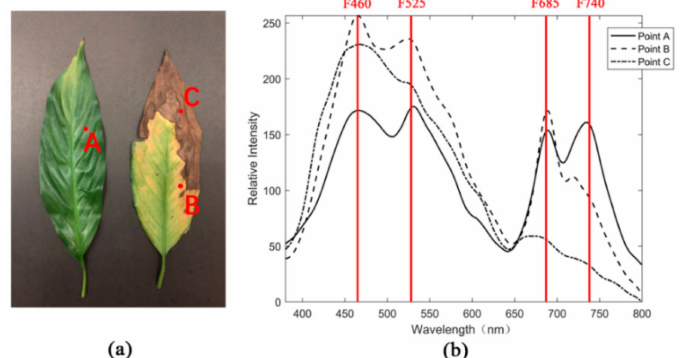
Figure 1. Induced continuous fluorescence spectrum of leaves in di ff erent physiological states excited with an UV laser. ( a ) Two leaves of di ff erent physiological states (Scene 1), and three points, namely A, B, and C, were located in fresh green, yellow, and brown areas, respectively; ( b ) continuous fluorescence spectrum of points A, B, and C excited with a UV laser (355 nm) was detected by the wavelength of 380–800